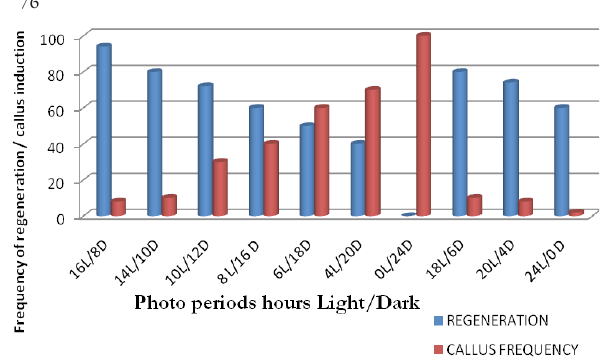
Fig. 2. Effect of photoperiod on